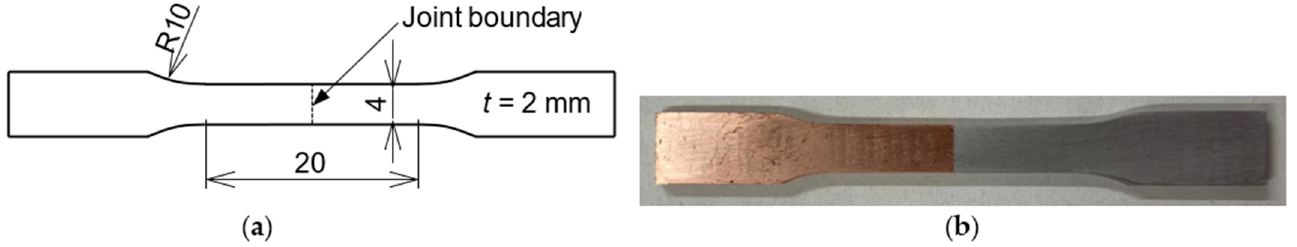
Figure 15. Tensile test specimen joined using shaved surface: ( a ) Schematic; ( b ) Photograph.